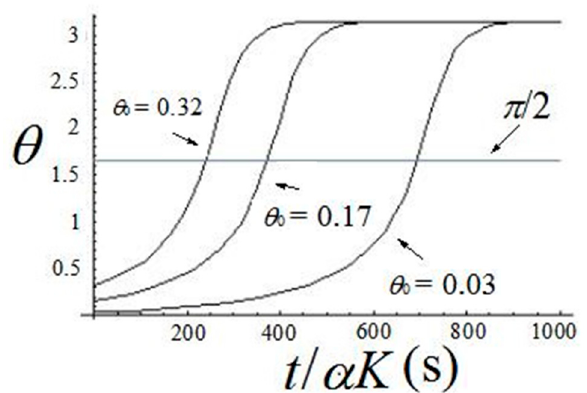
Figure 7. θ angle of the moment is analytically determined in terms of parameter t for three characteristic initial angles θ 0 of approximately 0.03 (~1.72°), 0.17 (~9.74°), and 0.32 (~18.33°). A solid straight line representing θ = π /2 acts as a guide for reference.